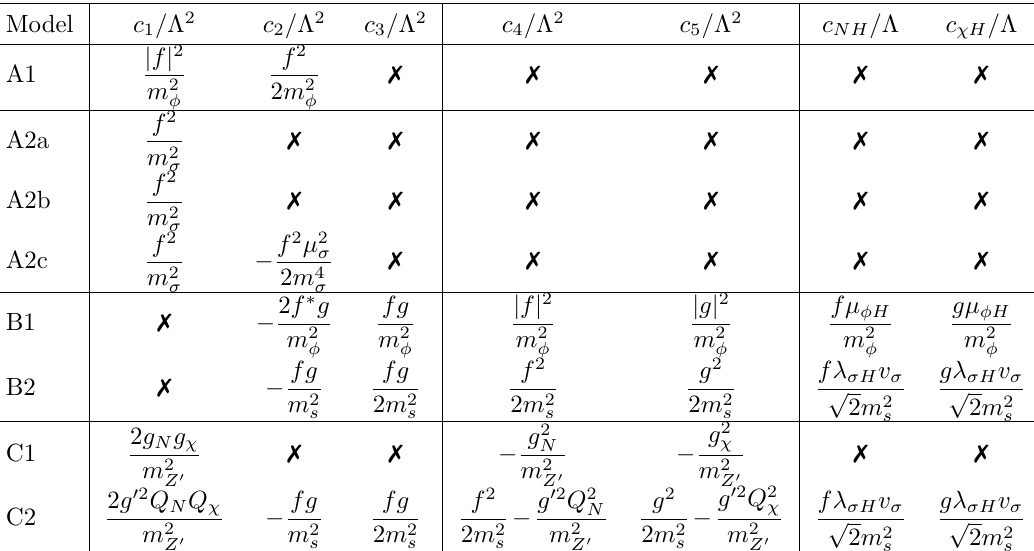
Table 3 . Matching conditions for the Wilson coefficients of the effective D ≤ 6 operators generated in renormalisable models by integrating out a scalar and/or vector mediator at tree level. The structure of the operators is detailed in table 1. Notice that in Model B1 with real g and Model B2 the relation c = − 2 c ∗ is satisfied and annihilations are p -wave, cf. eq. 2 3